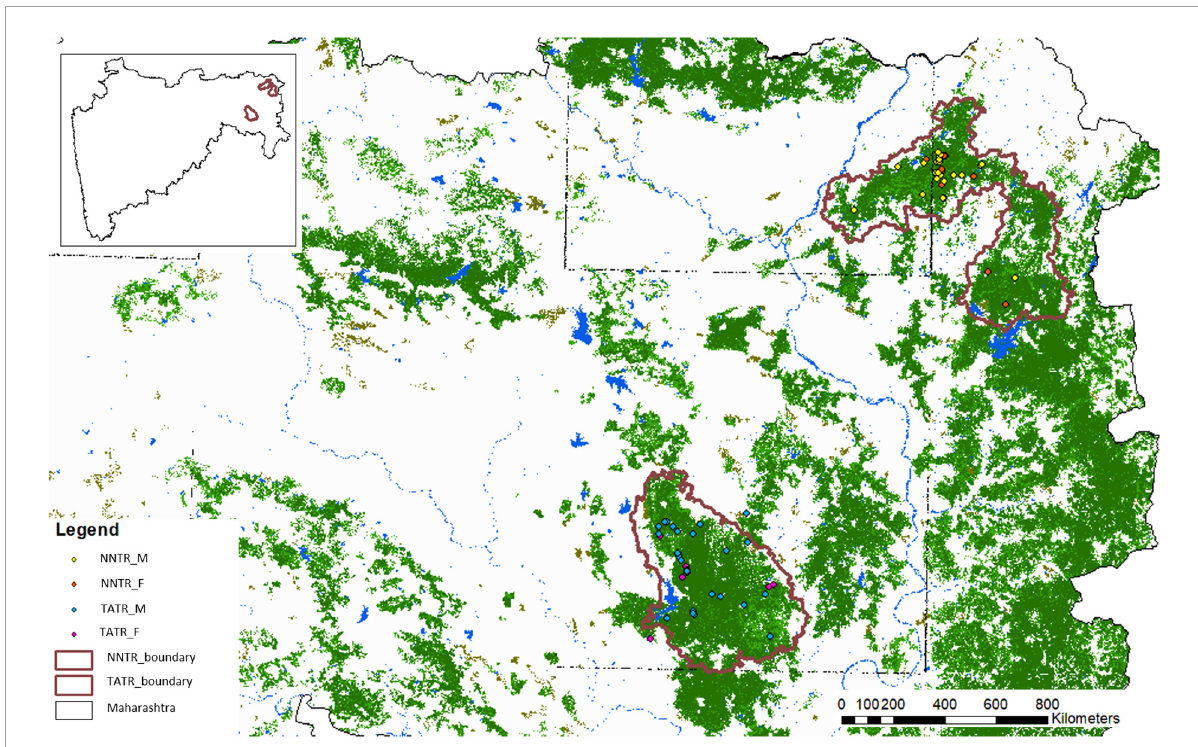
FIGURE1 Study area map with locations of identified male and female individuals in Nawegaon-Nagzira Tiger Reserve (NNTR) and Tadoba-Andhari Tiger Reserve (TATR). The inset map represents the geographical location of the tiger reserves in the state of